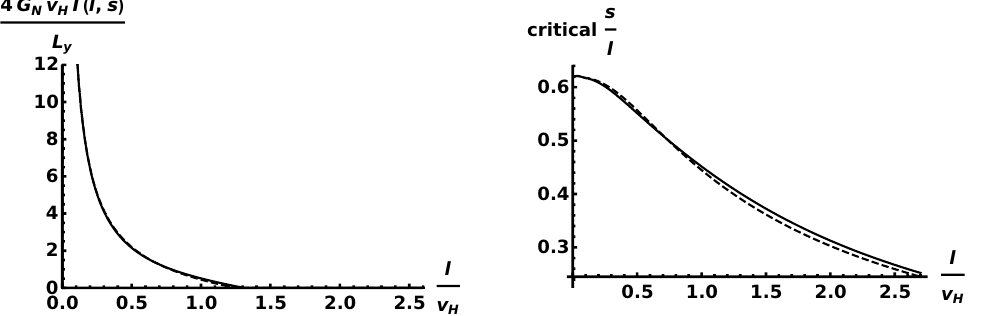
Figure 3 . Left : mutual information for the electron cloud geometry with T/µ = 0 . 02 correspond- ing to the parallel strip configuration with separation to length ratio s/l = 0 . 4 . The point where I ( A, B ) vanishes, corresponds to the phase transition between connected and disconnected phases. Right : the critical ratio s/l at which the phase transition happens as a function of l . In the UV, √ the ratio approaches the CFT value ( 5 − 1) / 2 . In the IR, the critical ratio tends to zero. Again, for comparison’s sake, in both figures we have also shown the results that are obtained in the pure RN case (dashed